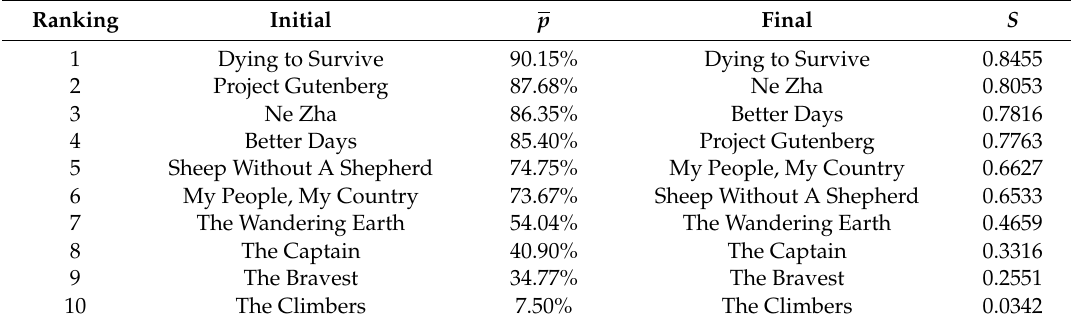
Table 3. Ranking comparison table.